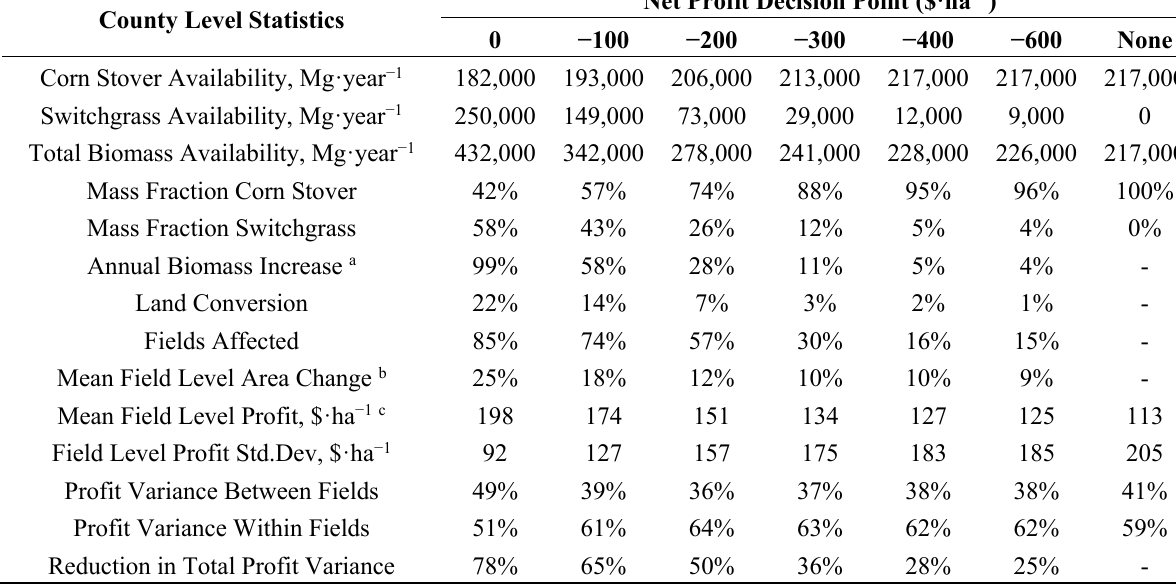
Table 1. Impacts of switchgrass integration at a range of profit decision points on: County level sustainable biomass availability, biomass distribution and land change, and field level profit impacts. Biomass availability values modeled for the rigorous conservation criteria (soil erosion < ½ T and SCI and SCI-OM > 0) using a grain price of 0.20 $·kg −1 . Land change and profit analyses are applicable to both stover removal scenarios.